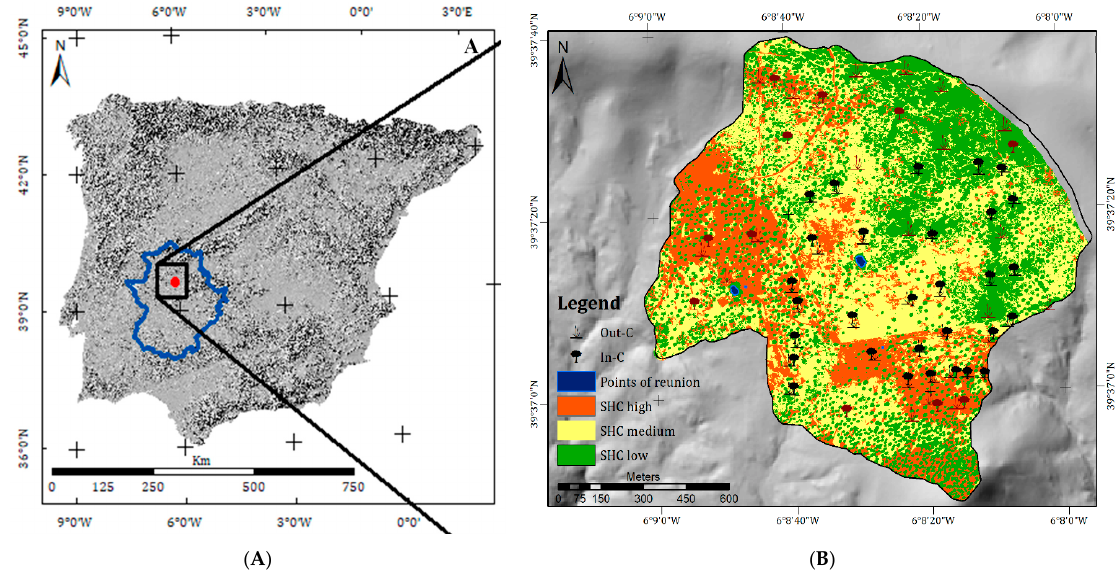
Figure 1. ( A ) Study area within the Extremadura region (blue boundaries) in the Iberian Peninsula and ( B ) the result of the object-based image analysis (OBIA) classification for the entire experimental catchment. Red indicates the ensemble of characteristics defining the SHC high area, yellow represents SHC medium , and SHC low is indicated by green. Sampling point distribution across the SHC categories is also shown: points sampled in spring are black and points added in autumn are indicated by dark red. A tree symbol (in-C; black or dark red) indicates the geographic location of a sampling point beneath the tree canopy; a grass symbol (out-C; black or dark red) indicates the geographic position of sampling points outside the canopy.